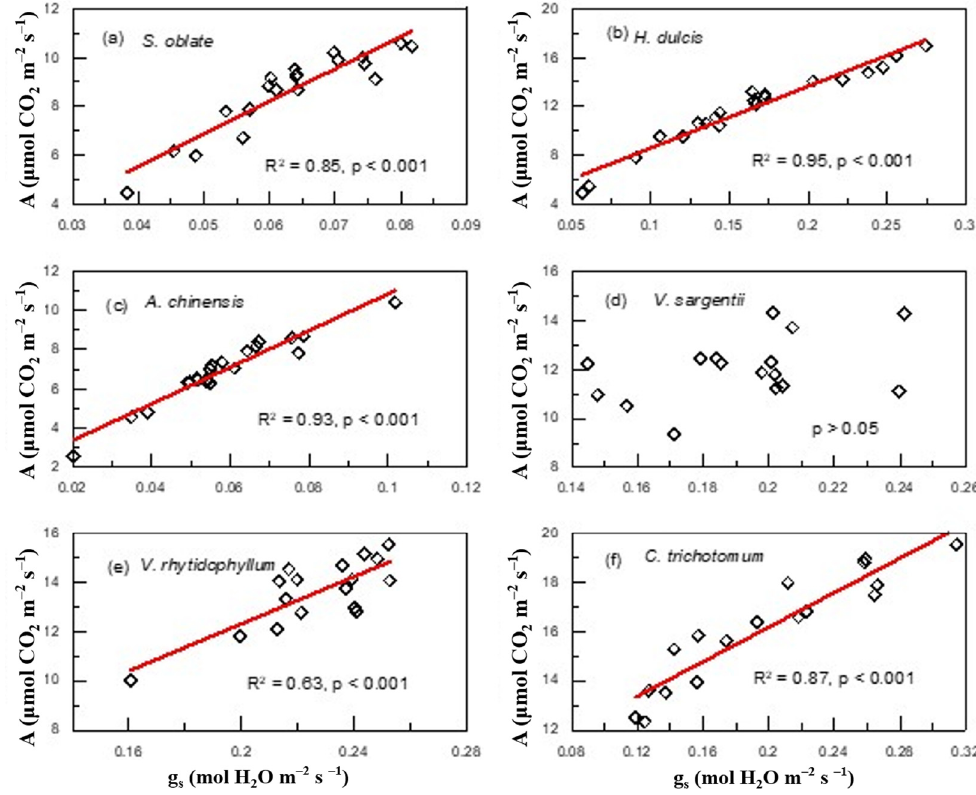
Figure 8. Relationships between stomatal conductance (g s ) and photosynthetic rate (A) at plant individual level for plants derived from the third sampling campaign: ( a ) S. oblate , ( b ) H. dulcis , ( c ) A. chinensis , ( d ) V. sargentii , ( e ) V. rhytidophyllum , ( f ) C. trichotomum We also assessed the photosynthetic N use efficiency (PNUE) of six plant species grown in the campus of CAU. PNUE is defined as the ratio of A and leaf N area , and it also links carbon cycle and nitrogen cycle in plants. The highest PNUE (126.95 μ mol CO 2 (mol N) − 1 s − 1 ) was in V. sargentii ; the second highest was in V. rhytidophyllum (115.78 μ mol CO 2 (mol N) − 1 s − 1 ). The PNUE was 42.86 μ mol CO 2 (mol N) − 1 s − 1 , 95.36 μ mol CO 2 (mol N) − 1 s − 1 ,